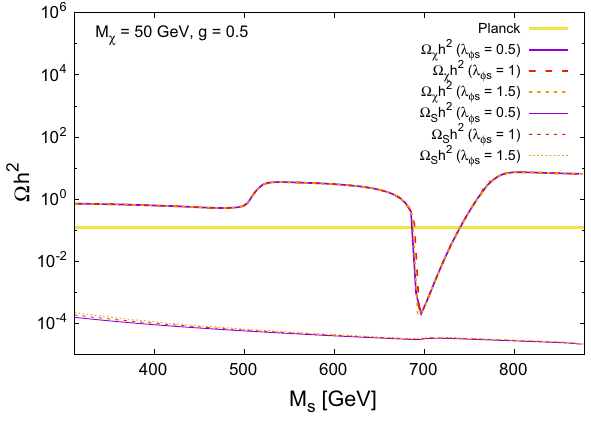
Fig. 3 The relic density as a function of the scalar DM mass for dif- ferent values of coupling λ φ s